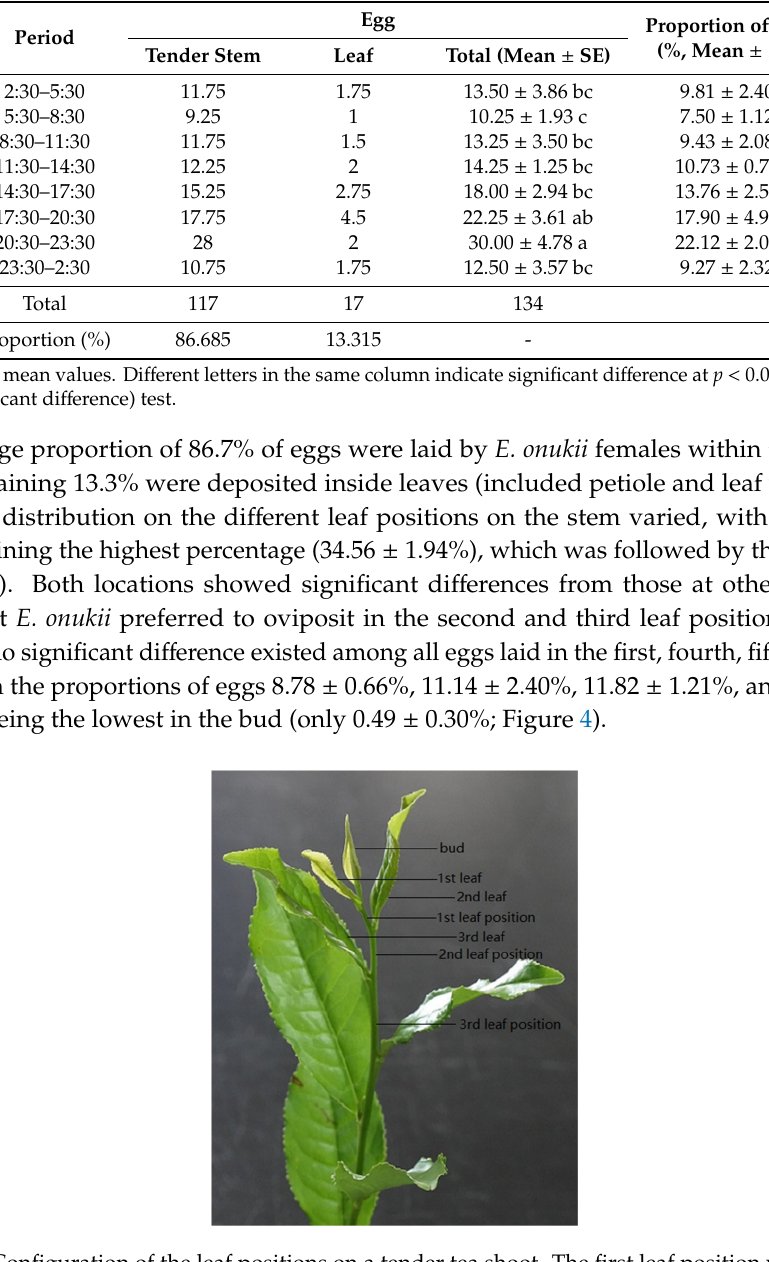
Table 5. Ovipositional rhythm and egg distribution of E. onukii.